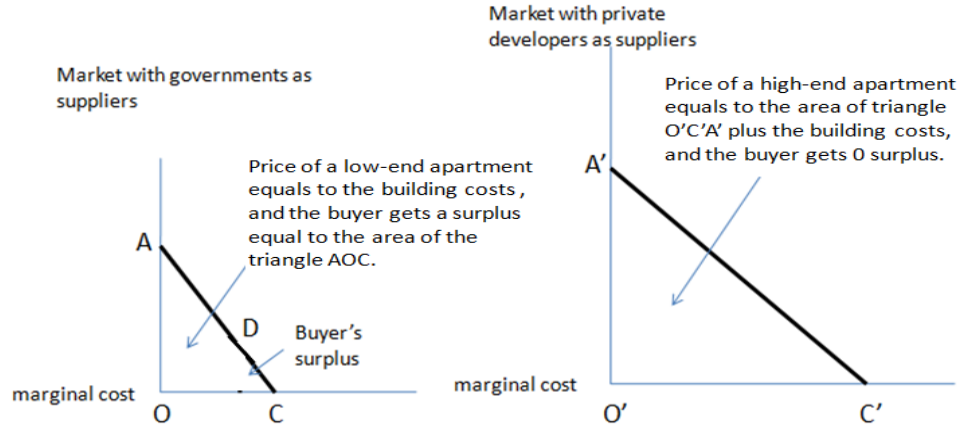
Figure 6. The effects of option 2.